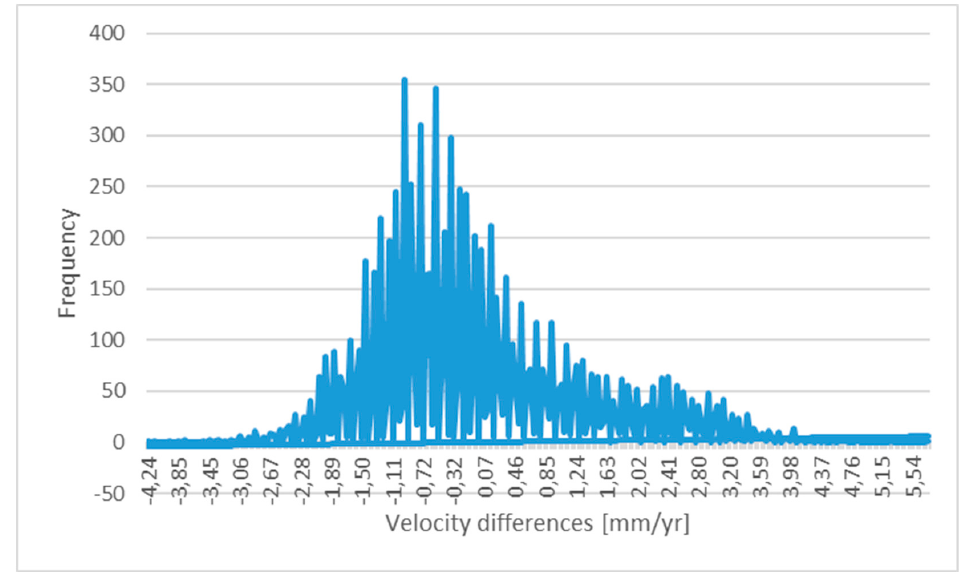
Figure 3. Histogram of the persistent scatterer interferometry (PSI) and TomoSAR velocity differences. Table 1. Statistics of the results of intercomparison over the first test area. Parameter Min. Max. Mean St. Dev. VELO [mm/year] − 4.24 5.54 0.01 1.36 RTE [m] − 18.06 32.80 0.09 3.25 THER [mm/°C] − 0.310 0.260 − 0.005 0.078